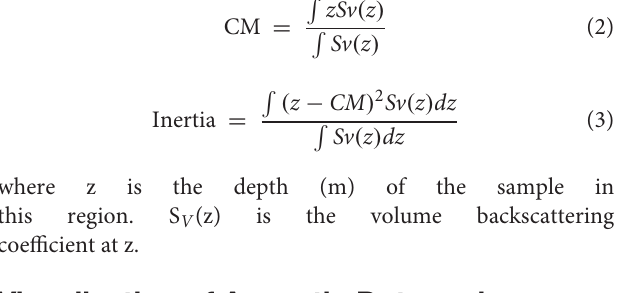
at depths of 200–800 m ( Figure 2 ). Acoustic scatterers